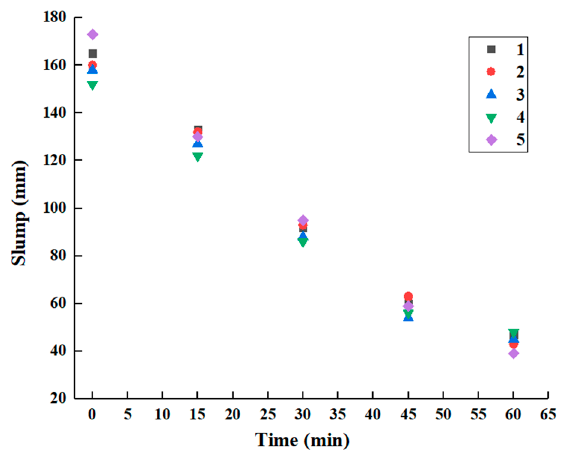
Figure 1. The change in slump with